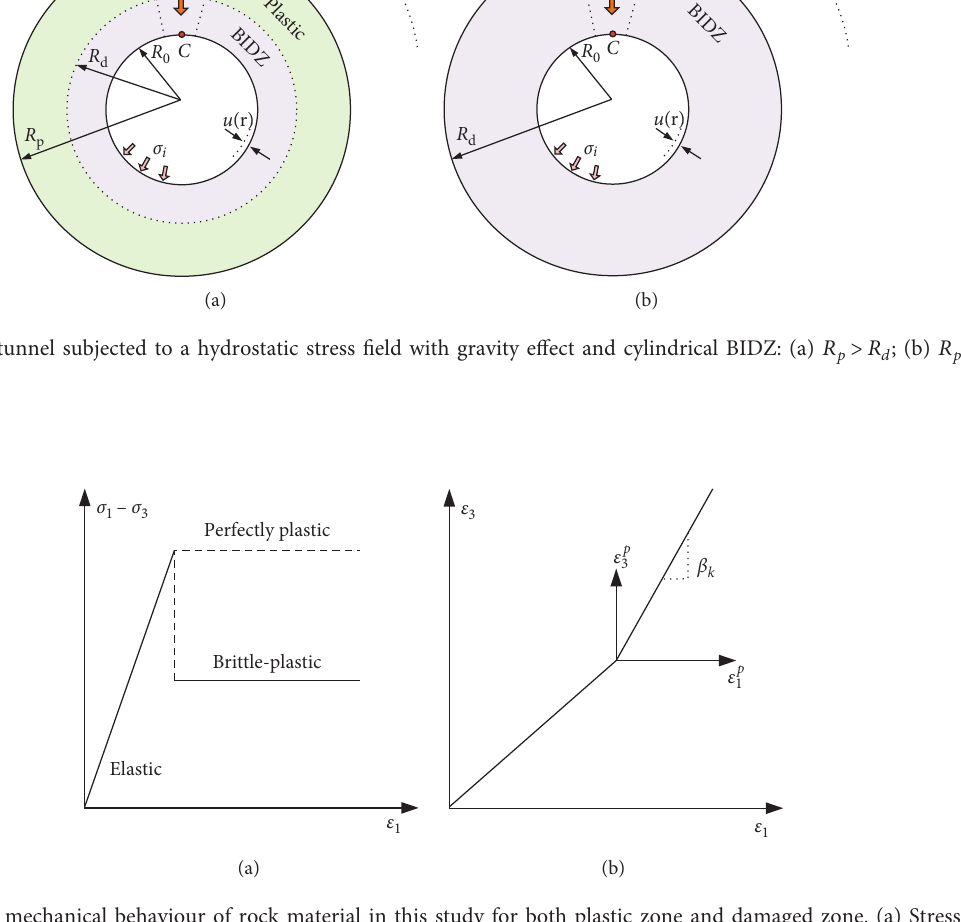
Figure 3: Simplified mechanical behaviour of rock material in this study for both plastic zone and damaged zone. (a) Stress-strain re- lationship; (b) flow